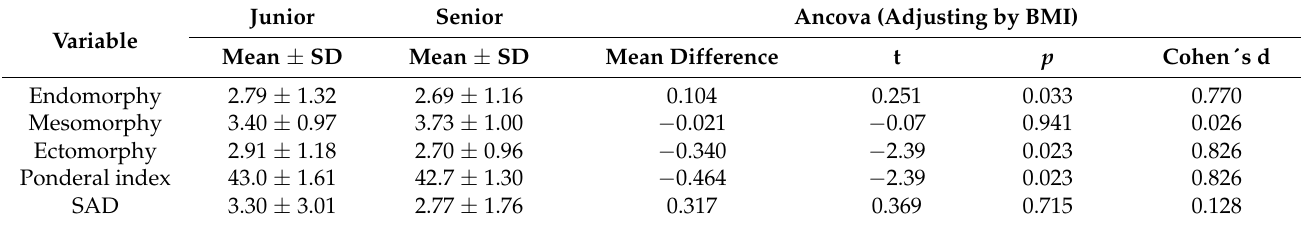
Table 4. Somatotype components and difference between male and female players.